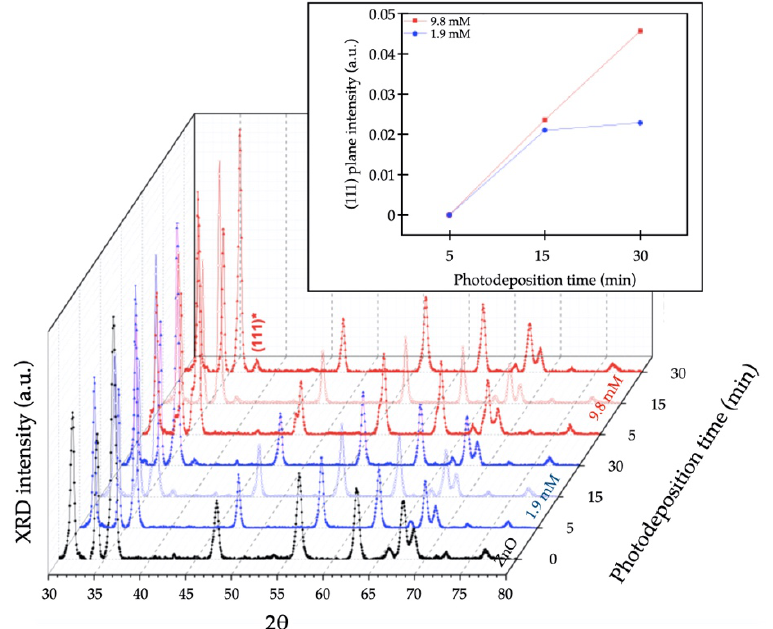
Figure 5. XRD pattern of ZnO MSs (black line) and Ag/ZnO MSs synthetized at 1.9 (blue lines) and 9.8 mM (red lines) of AgNO 3 during 5, 15, and 30 min. The inset shows the intensity variation of the (111) plane associated to the Ag